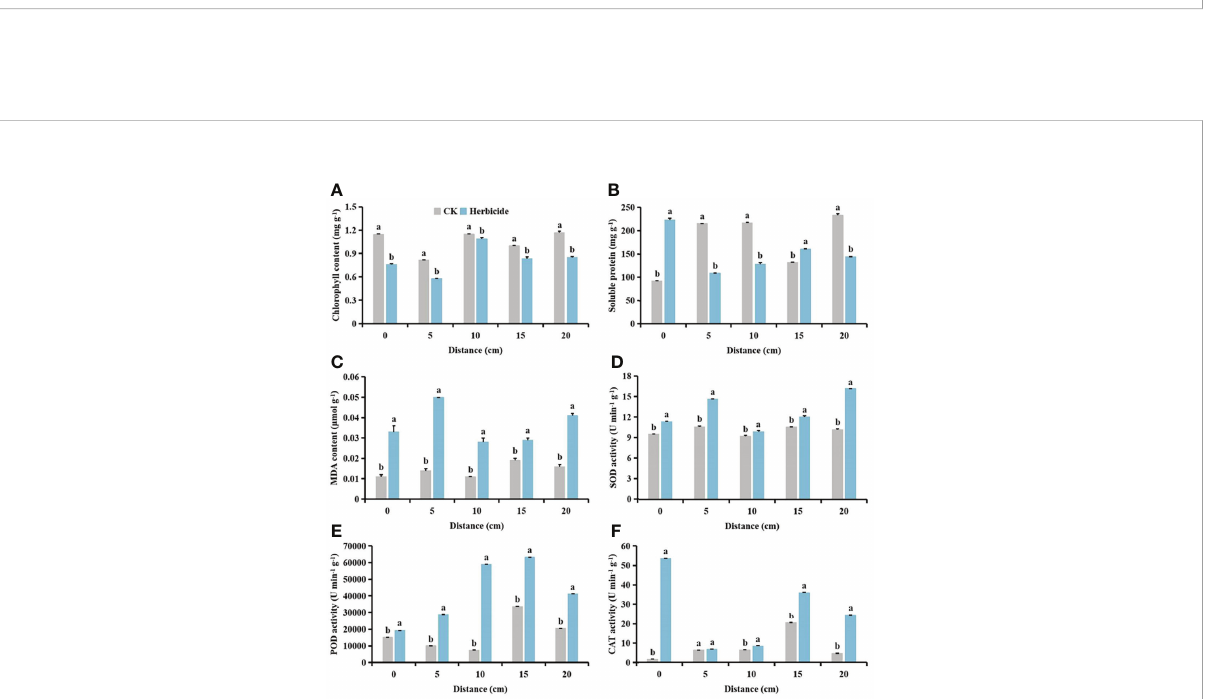
FIGURE 14 Effects of no herbicide application and spraying 0.015 g L -1 75% tri fl oxysulfuron + 4 g L -1 , 40% prometrynon (A) chlorophyll, (B) soluble protein and (C) malondialdehyde (MDA) content, and (D) superoxide dismutase (SOD), (E) peroxidase (POD) and (F) catalase (CAT) activities in cotton at different spatial distribution distances. CK, no herbicide application: Herbicide, spraying 0.015 g L -1 75% tri fl oxysulfuron + 4 g L -1 40% prometryn. The mean value ± standard data were presented in the fi gure. Different alphabetical letters indicate the signi fi cant differences between CK and herbicide ( p